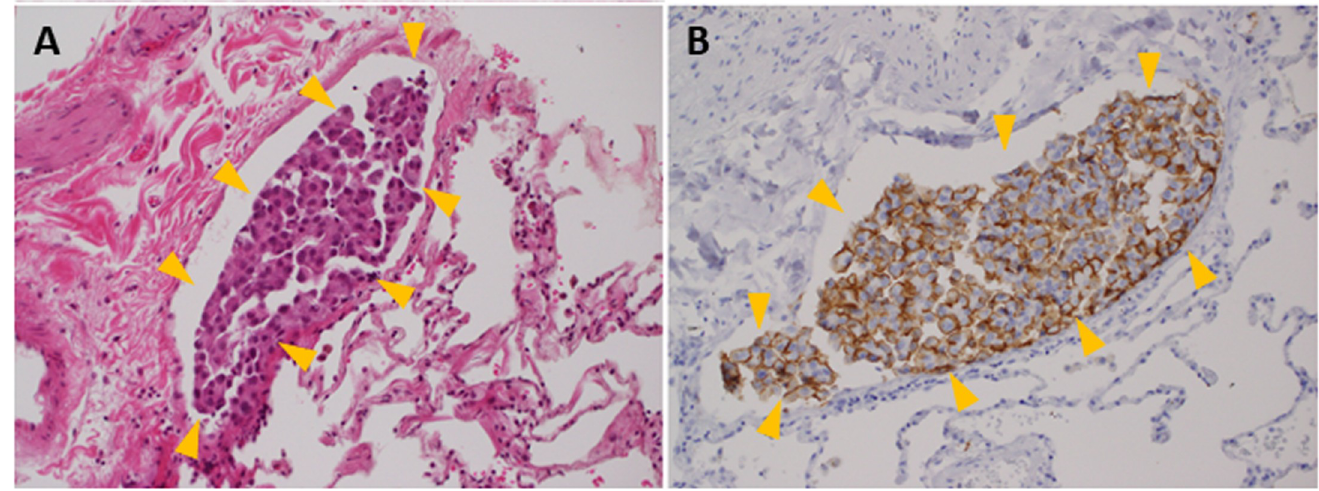
Fig 5. Representative images of lymphatic canal invasion in a MUC21D high expressor (A, hematoxylin and eosin stain; B, immunohistochemistry for MUC21D). A cluster of tumor cells (yellow arrowhead) strongly expressing MUC21D, which was a mixture of solid and micropapillary elements, filled a lymphatic canal. Magnification of all images is 200 × .